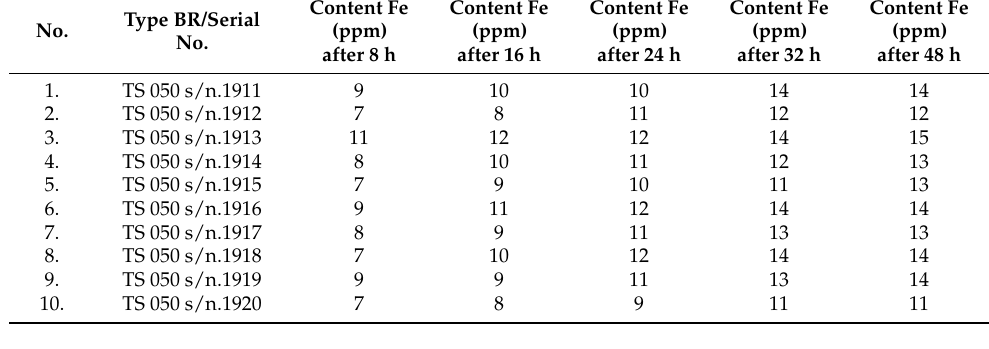
Table 8. Solid abrasive particle values over 48 h of the BR TS 050 trial run.